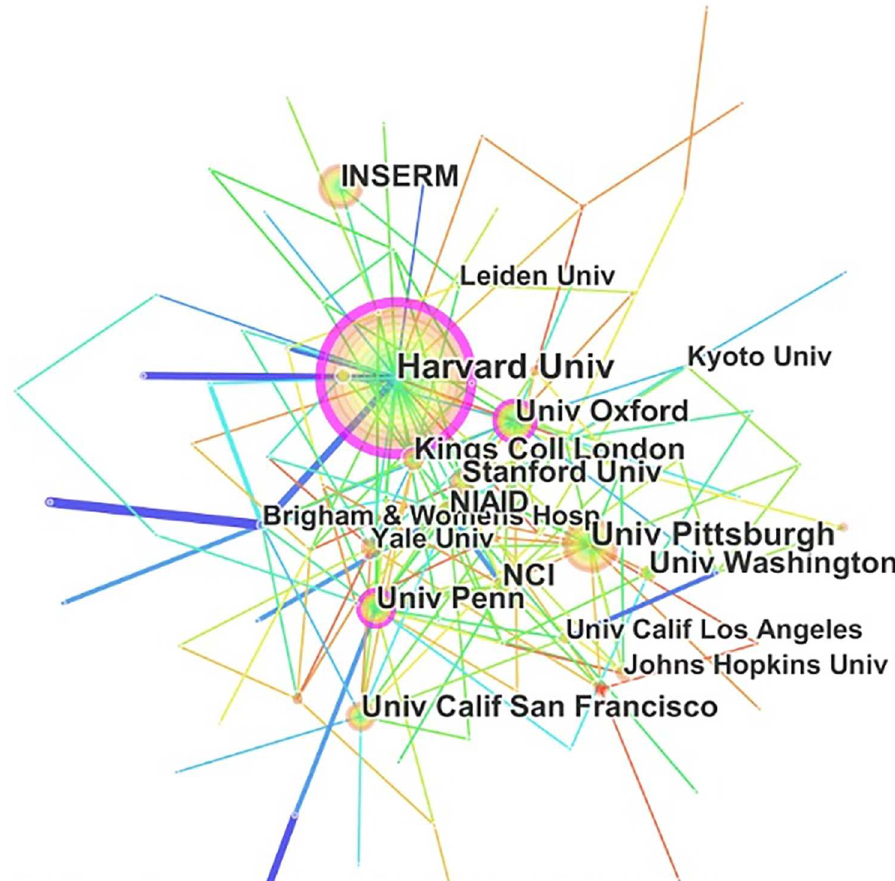
Fig 3. Institutions thatpublished articlesrelatedto regulatory T cell (Treg) research from 2000 to